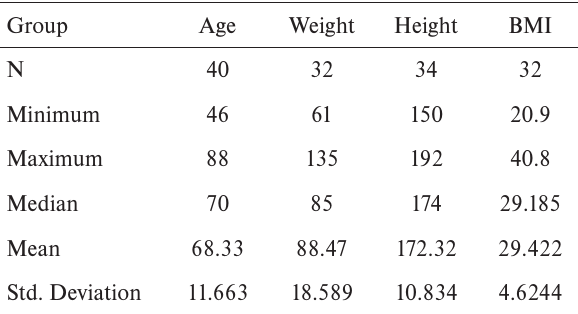
Table 3. Anthropometric data of the